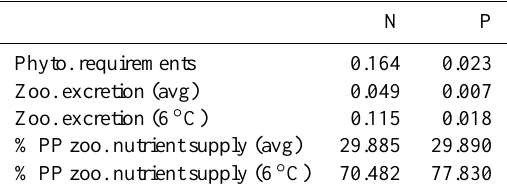
Table 7. Comparison between the N and P daily required by phytoplankton for primary production, and zooplankton supply (gm − 2 day − 1 ) and contribution to phytoplankton requirements (%) at average temperature (2.7 ◦ C) and for predicted 6 ◦ C